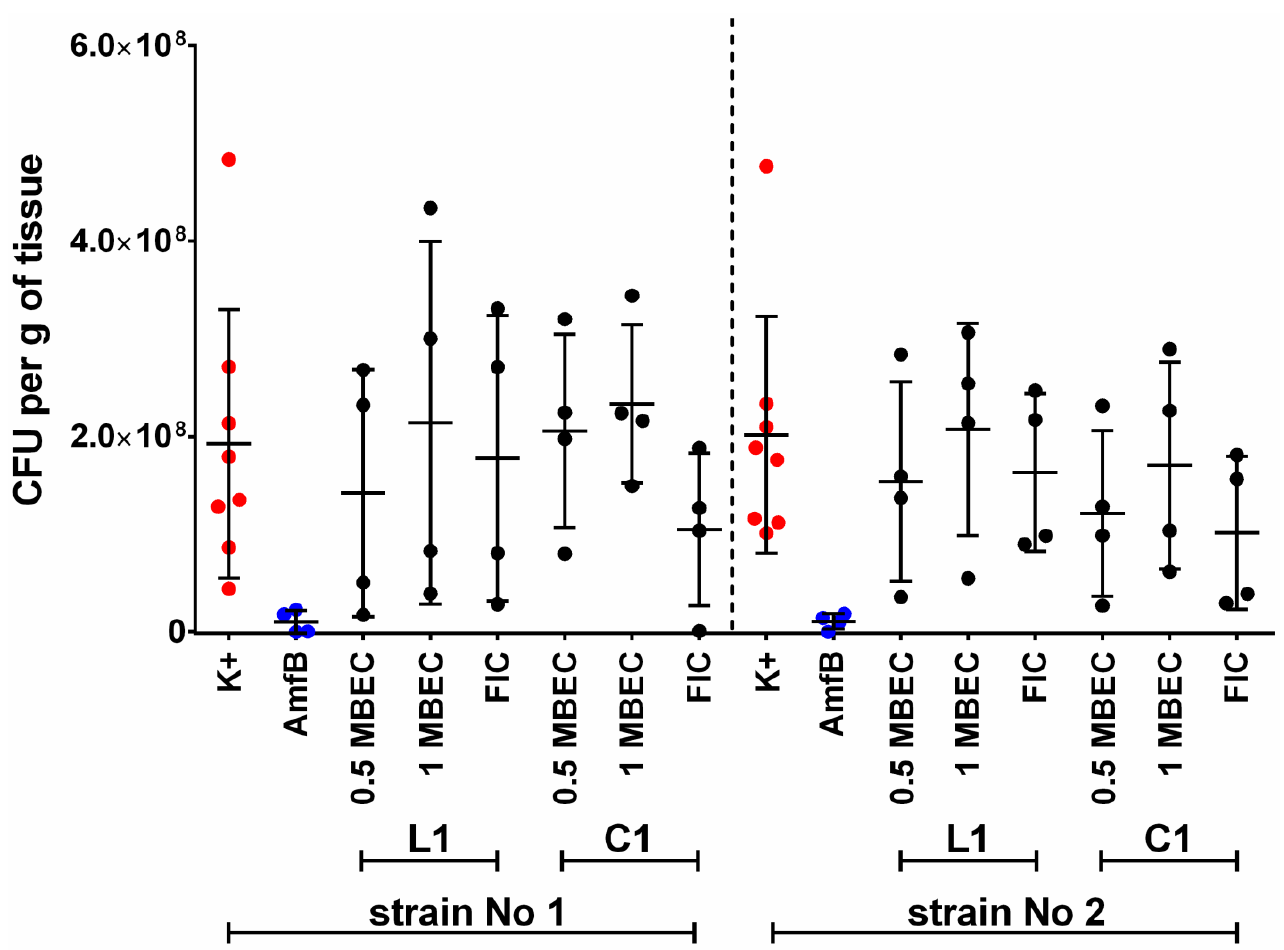
Figure 2. Distribution of CFU per gram of tissue values obtained for strains CA1 and CA2 in all courses of experiments. K(+) is referred to as a positive control (untreated biofilm of C. albicans ). Biofilms were treated with: AMB — amphotericin B (50 µg/mL), lipopeptides L1 and C1 at a concentration equal to MBEC, ½ MBEC, and FIC values (MBEC — minimum biofilm eradication concentration; FIC — fractional inhibitory concentration).